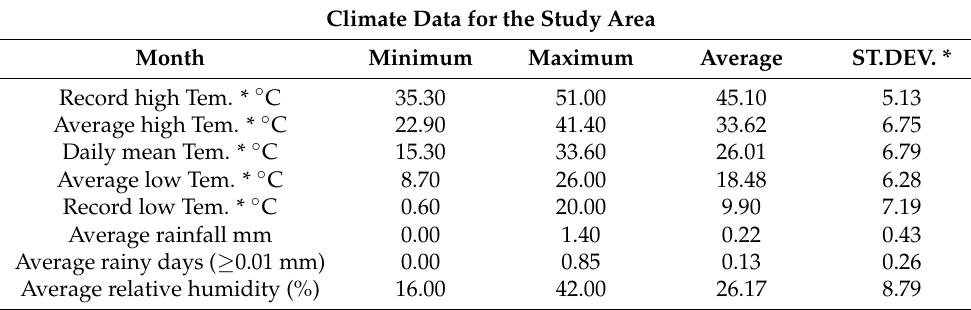
Table 1. Meteorological data of the investigated area. Climate Data for the Study Area